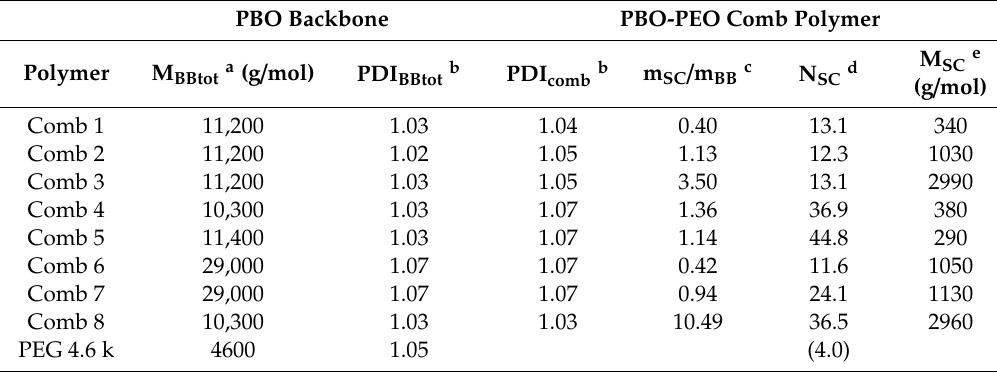
Table 1. Molecular weight characterization of the comb